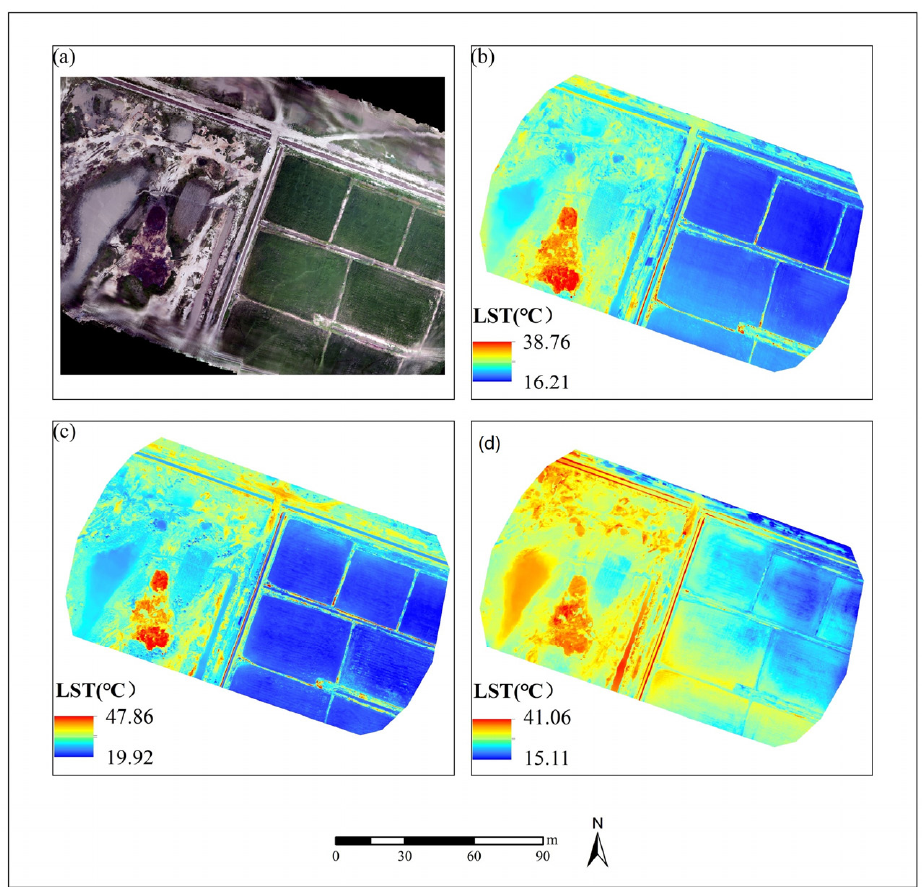
Figure 7. UAV visible-light images of saline–alkali land and paddy fields in the experiment field of Da’an City, western Jilin Province: ( a ) the spatial distribution of UAV surface temperature at morning, ( b ) noon ( c ) and evening ( d ).